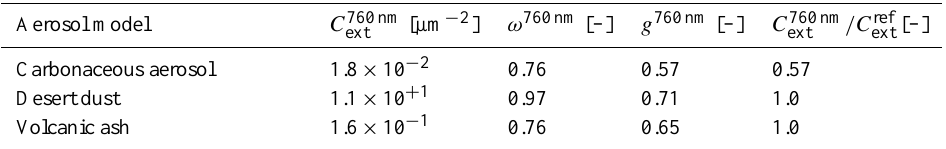
Figure 3. Results of retrieval simulations showing the bias in retrieved aerosol layer mid pressure as a function of the true single scattering albedo for three different a priori errors in the surface albedo. The single scattering albedo assumed in retrieval is 0.95 (“model value”). The aerosol layer is over sea (albedo of 0.03, left panel) or over land (albedo of 0.2, right panel). Missing data points indicate non-converging retrievals. Other details are the same as in Figs. 1 and 2. Table 3. Summary of aerosol models used in the sensitivity study of Sect. 3. The table lists the extinction cross section ( C ext ), single scattering albedo ( ω ) and asymmetry parameter ( g ) at 760nm, and the ratio of the extinction cross section at 760nm to the extinction cross section at the reference wavelength. The reference wavelength is 550nm for the carbonaceous aerosol and desert dust model and 630nm for the volcanic ash